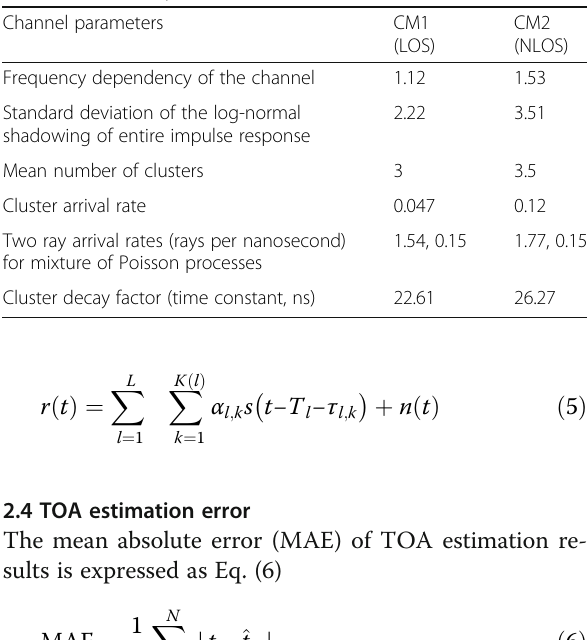
Table 2 Channel parameters of CM1 and